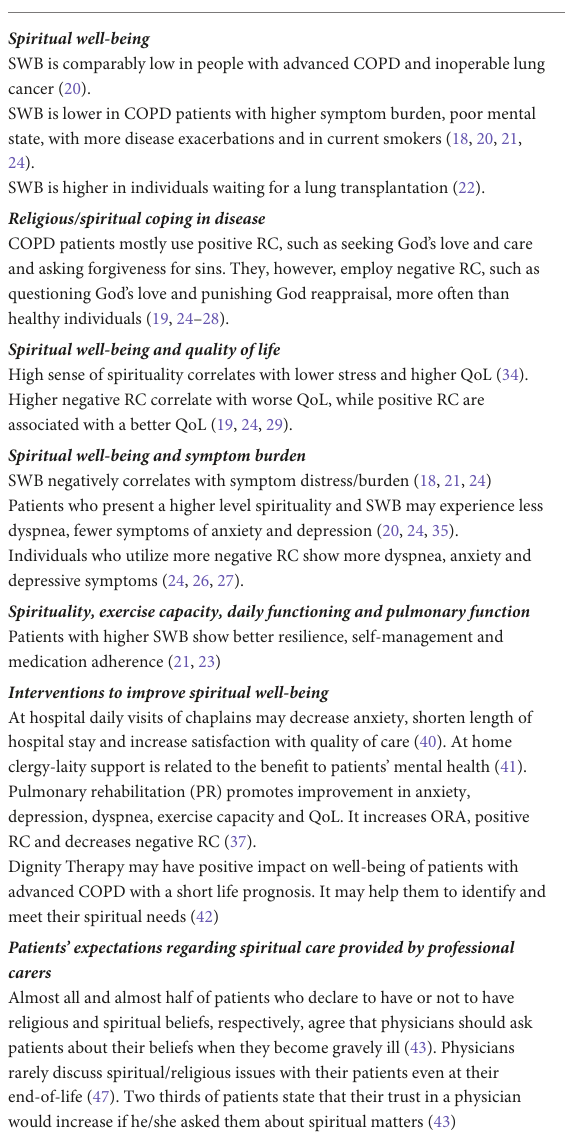
TABLE 1 Benefits and impacts of spirituality among patients with COPD according to the literature. Main